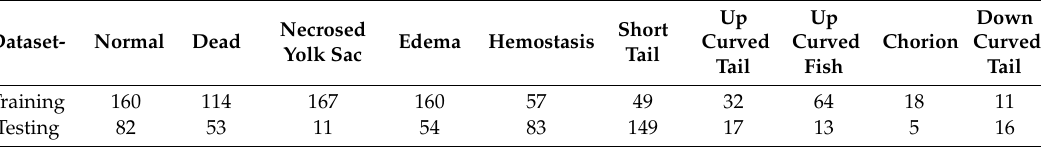
Table 1. The number of training and testing zebrafish larvae microscopic images of each phenotype.